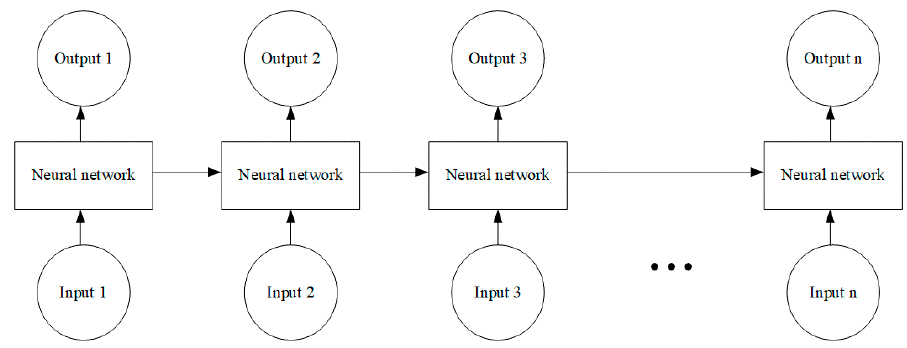
Figure 8. The structure of the Recurrent Neural Network (RNN). Figure 6. The structure of the Recurrent Neural Network (RNN).